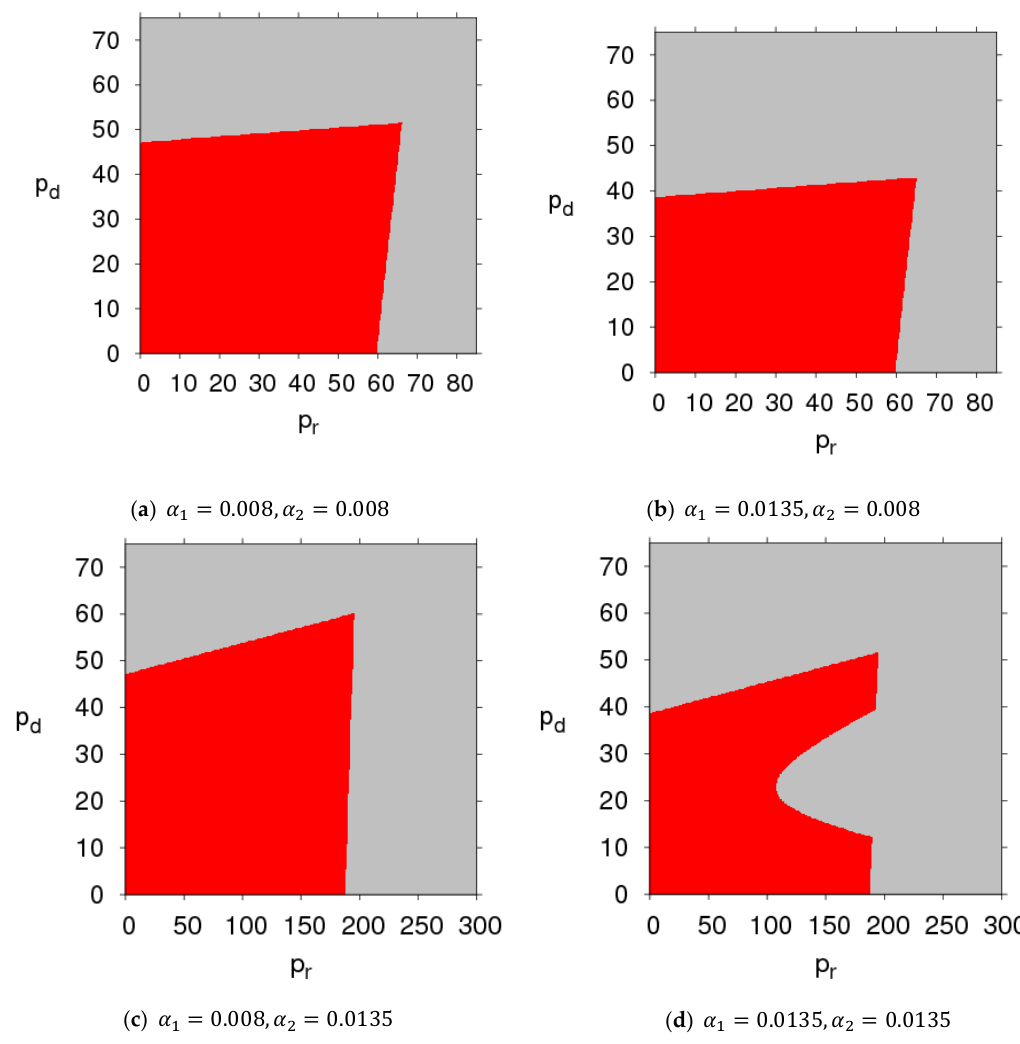
Figure 19. Basins of attraction of dynamic System (7).